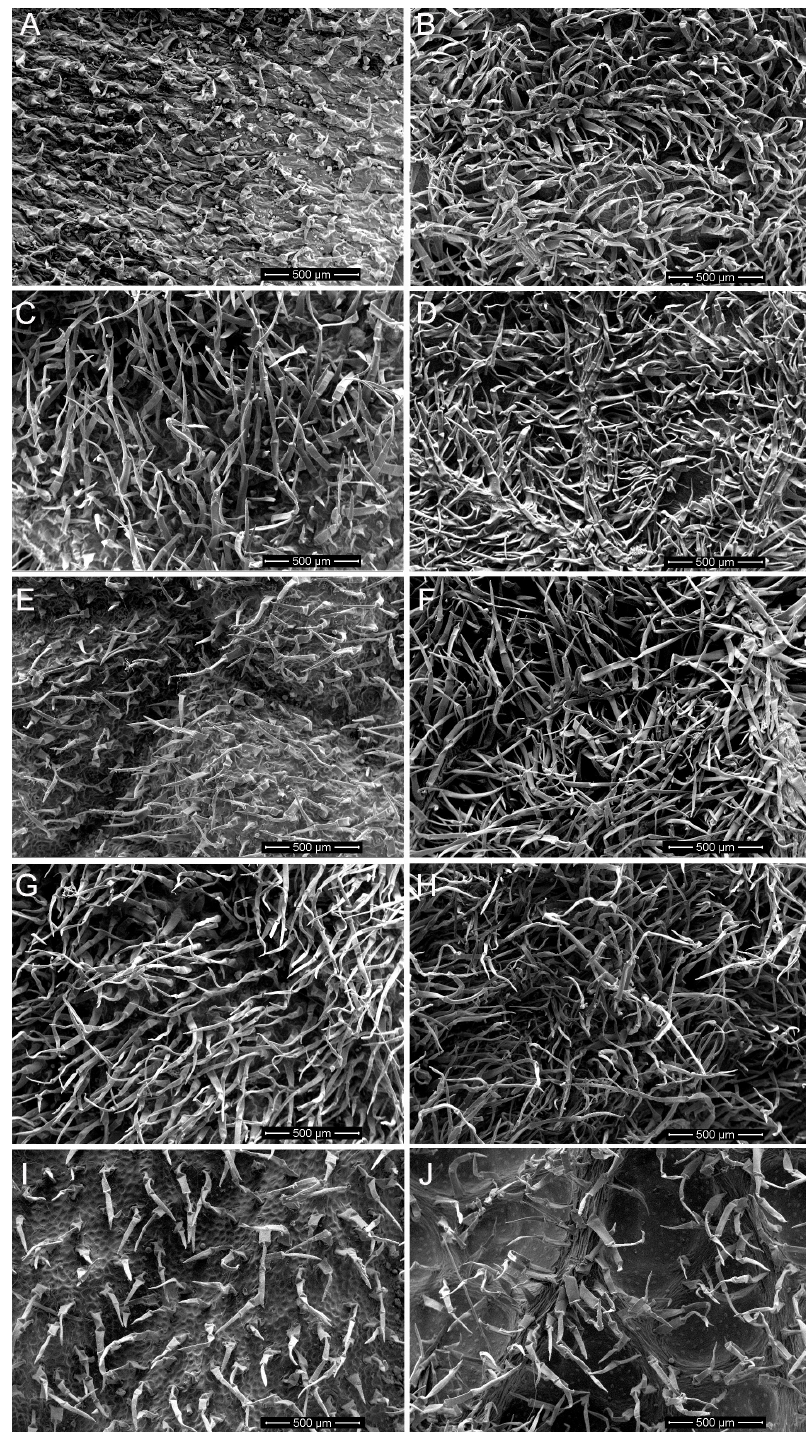
Fig. 7. Comparison between the pubescence of the leaves of the species (photos taken under electron microscope). A, C, G, E, I . Adaxial surface. B, D, F, H, J . Abaxial surface. A–B . Stachytarpheta brevibracteata (Moldenke) P.H.Cardoso ( P.H. Cardoso & W.P. Leite 66 ). C–D . S. longipedicellata (Moldenke) P.H.Cardoso ( P.H. Cardoso et al. 59 ). E–F . S. longispicata (Pohl) S.Atkins ( P.H. Cardoso et al. 48 ). G–H . S. minasensis (S.Atkins) P.H.Cardoso ( F.R.G. Salimena & P.H. Nobre 459 ). I–J . S. ratteri (S.Atkins) P.H.Cardoso ( P.H. Cardoso et al. 51